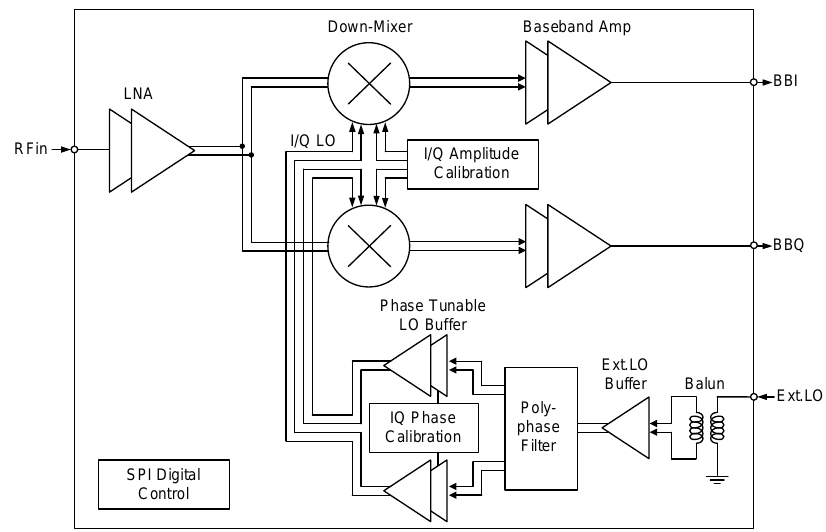
Figure 2. The 24 GHz direct-conversion RF receiver architecture.